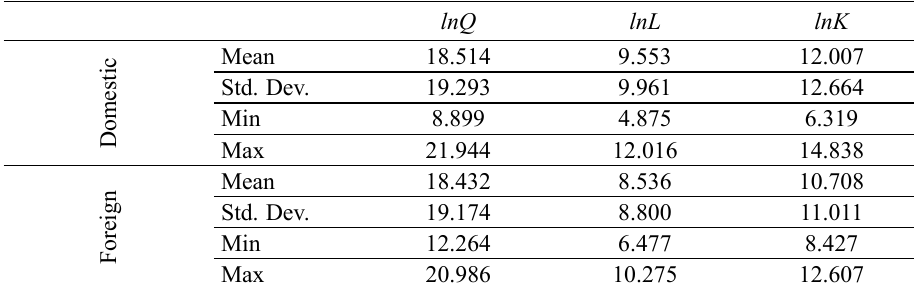
Table 1. Descriptive Properties of the Data in Logarithmic Values